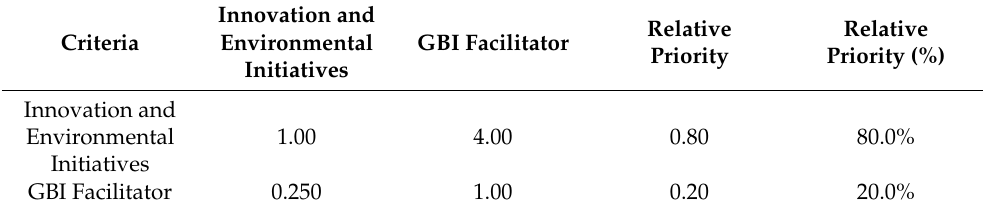
Table 7. Paired comparison matrix for the innovation (IN) attribute in %.